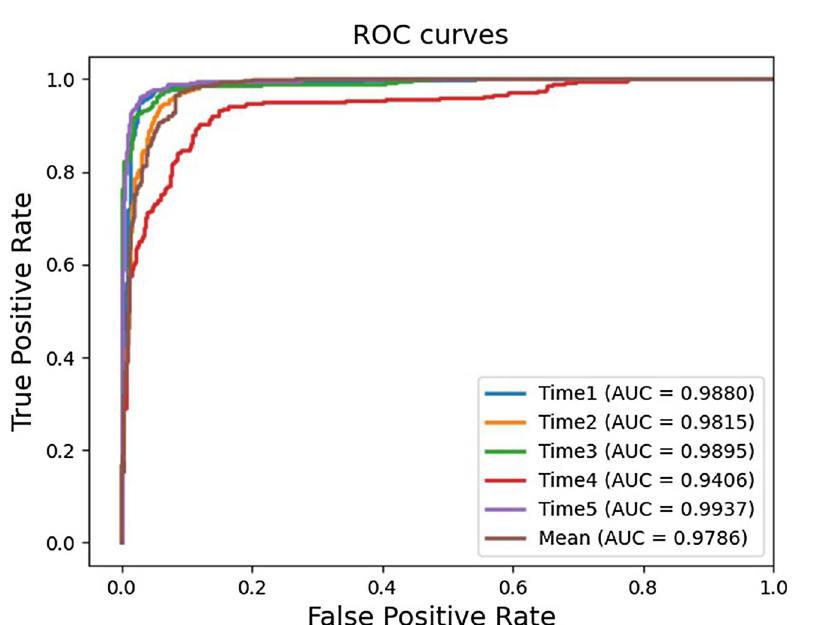
Figure 2. Performance of HGNNLDA and its